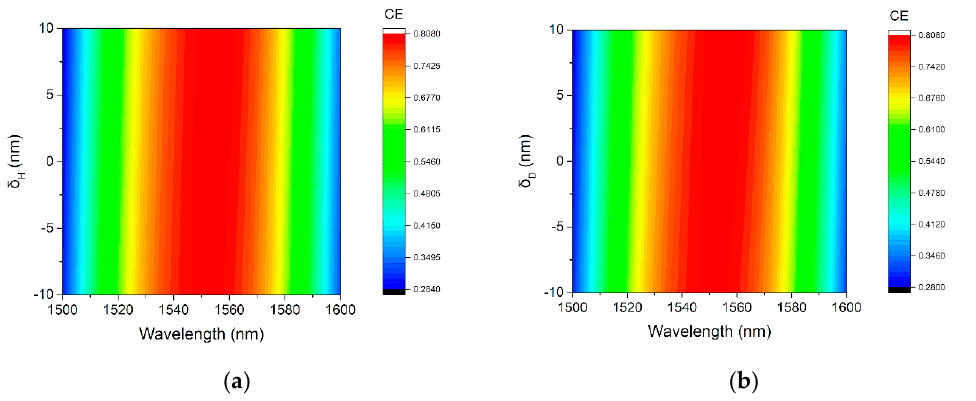
Figure 10. Fabrication tolerances of the CE: ( a ) Thickness error of the Si 3 N 4 layer. ( b ) Thickness error of the SiO 2 between grating and Si 3 N 4 layer.